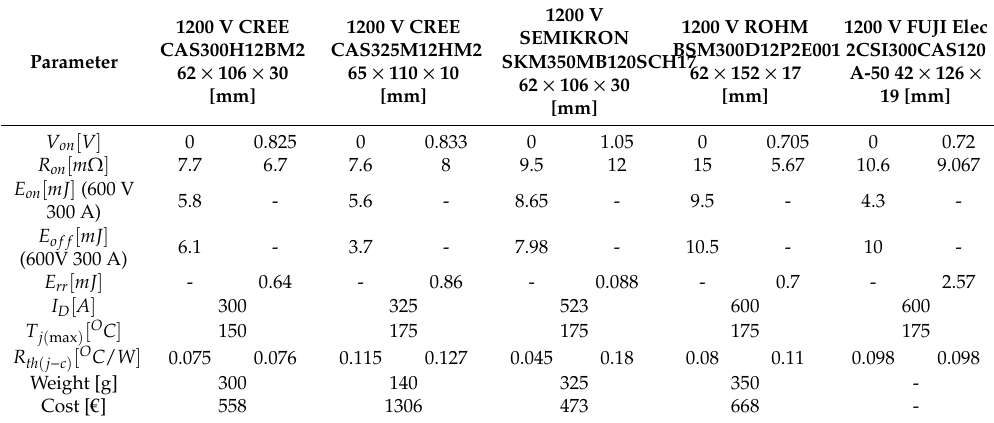
Table A1. Commercially available SiC power modules.